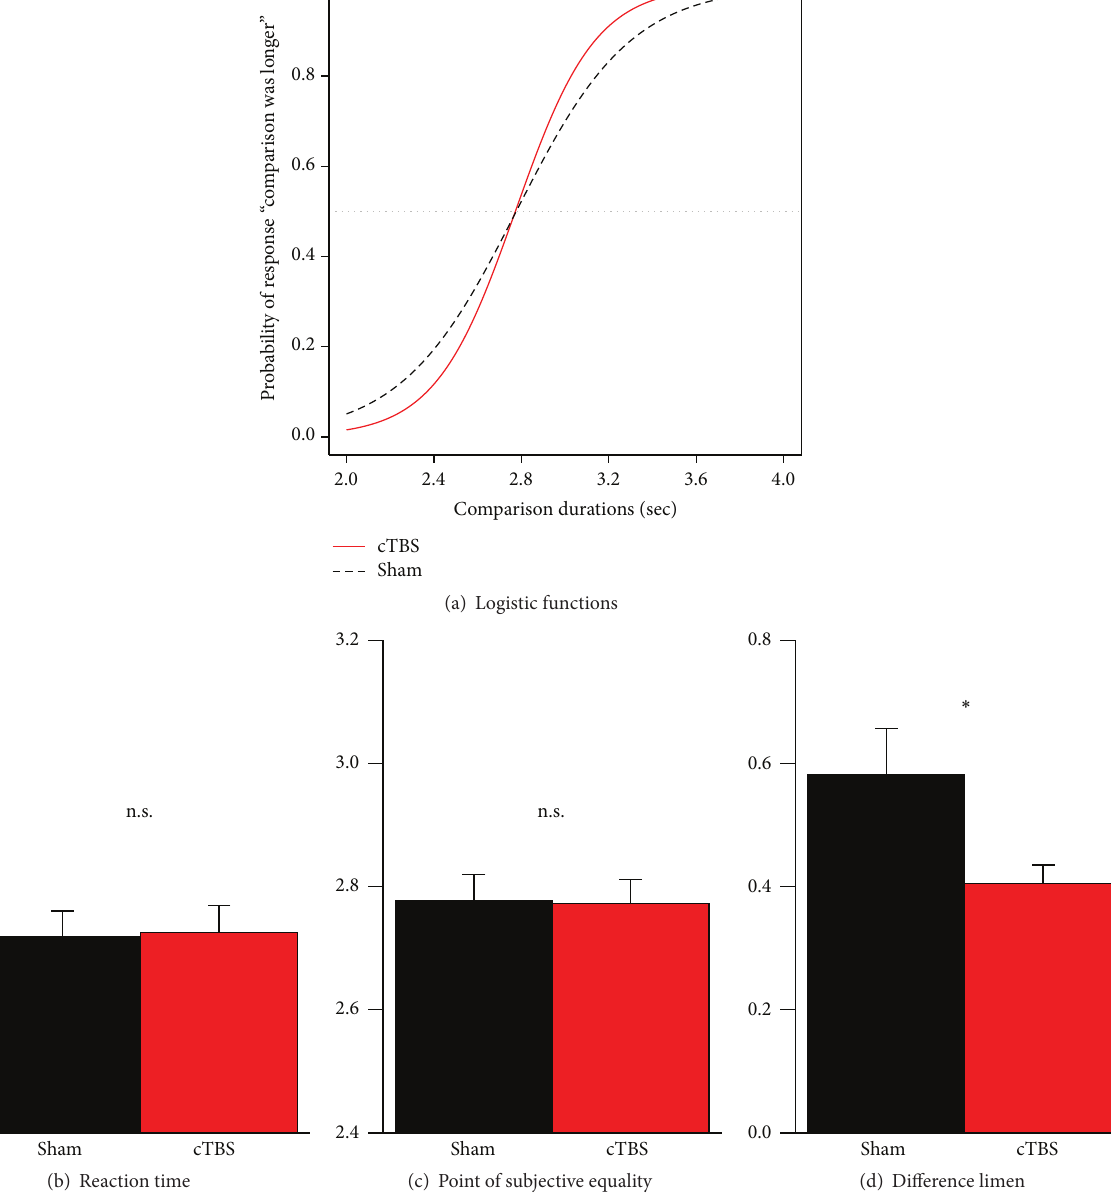
Figure 3: (a) Averaged logistic functions according to the discrimination data. No differences between cTBS (red bars) and sham stimulation (black bars) were found for reaction times (b) and the point of subjective equality (c). In contrast, reduction of the difference limen (d) indicates increased precision and thus a higher judgment certainty after cTBS. Error bars show standard errors of the mean across